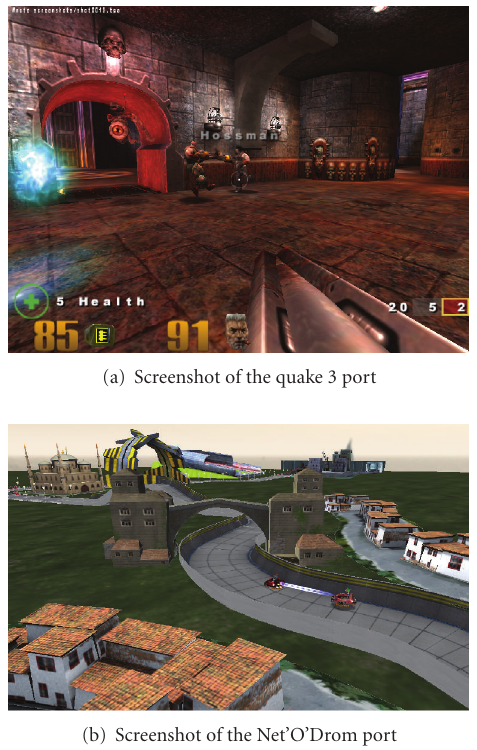
Figure 18: Existing games that are ported onto